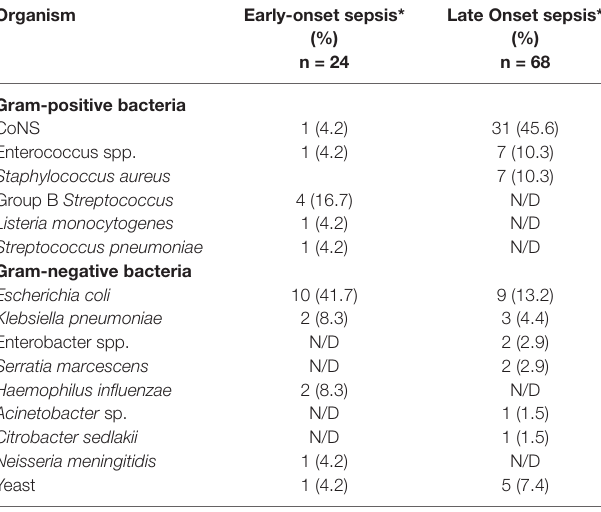
TABLE 2 | Pathogens identified in culture-confirmed sepsis. Organism